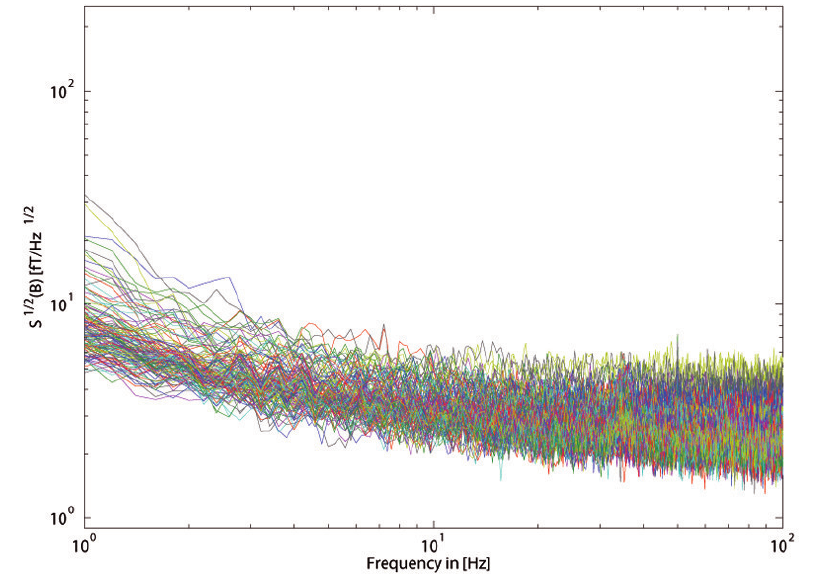
Figure 4. Magnetic field noise spectral density measured at T = 4.2 K for all of the SQUID magnetometers inside the magnetoencephalography (MEG) dewar are reported. For frequencies greater than a few Hz, the noise is essentially independent of the frequency (white noise), and its value is as low as 5 fT/Hz 1 / 2